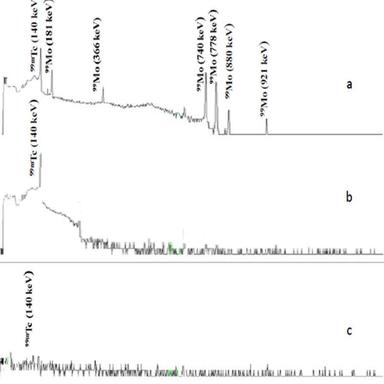
Radionuclidepurity of the eluted 99mTC from mesoporous ( 99Mo–MnO2/MWCNT) generator.